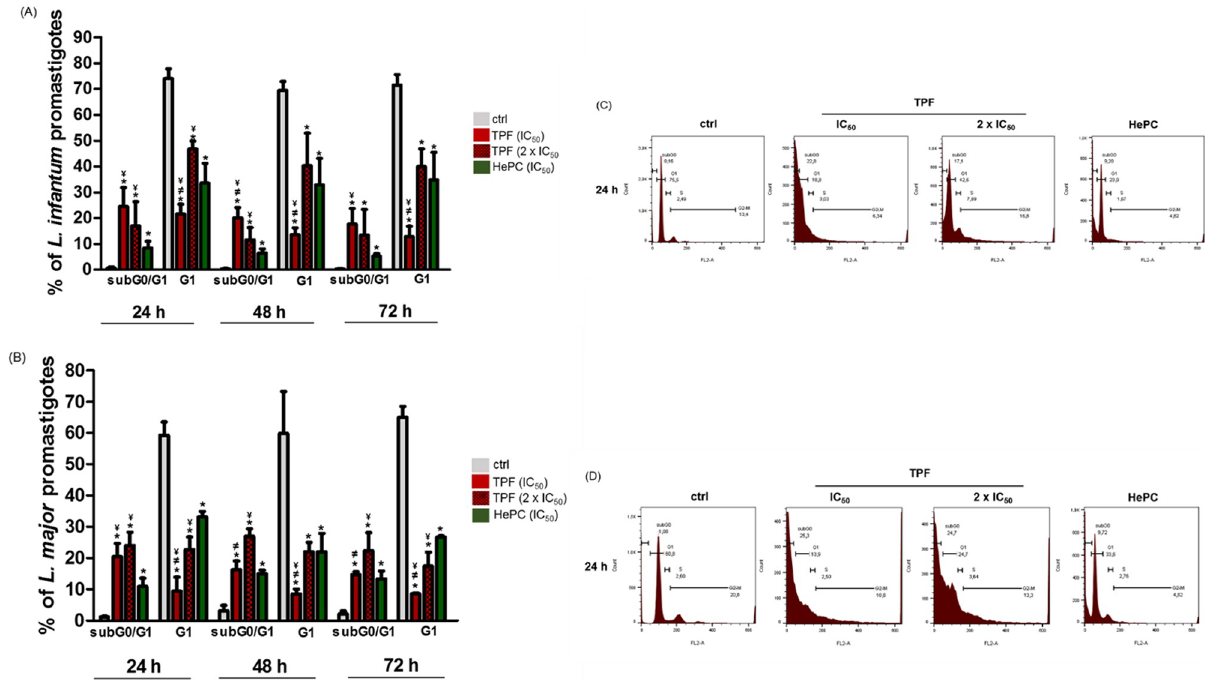
Fig 5. Analysis of cell cycle arrest in TPF-treated L . infantum and L . major promastigotes.